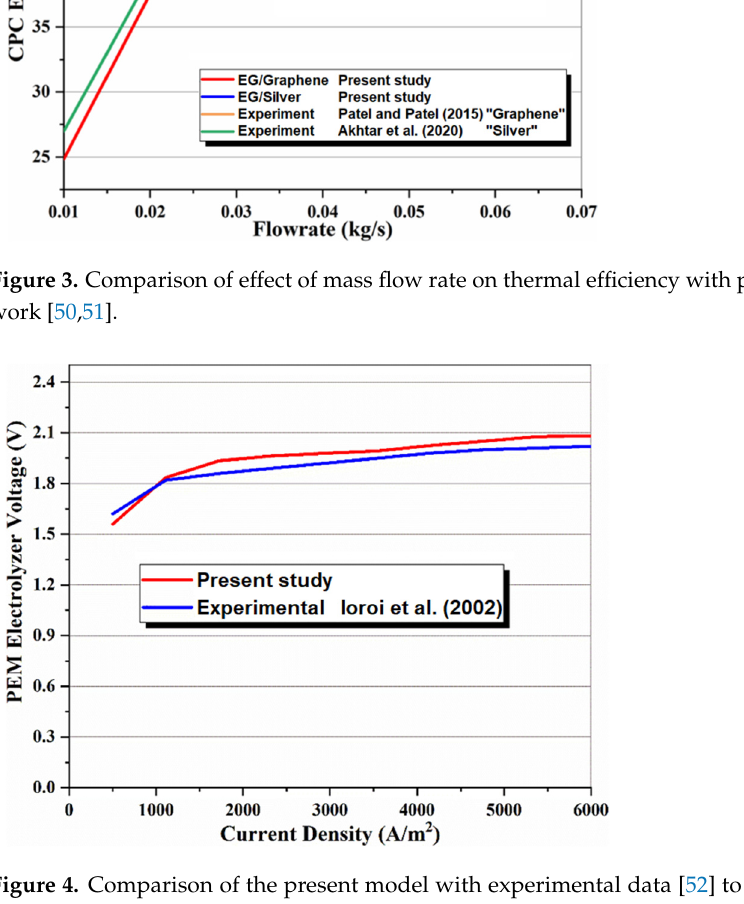
Figure 4. Comparison of the present model with experimental data [52] to validate the PEM electrolyzer model [52].